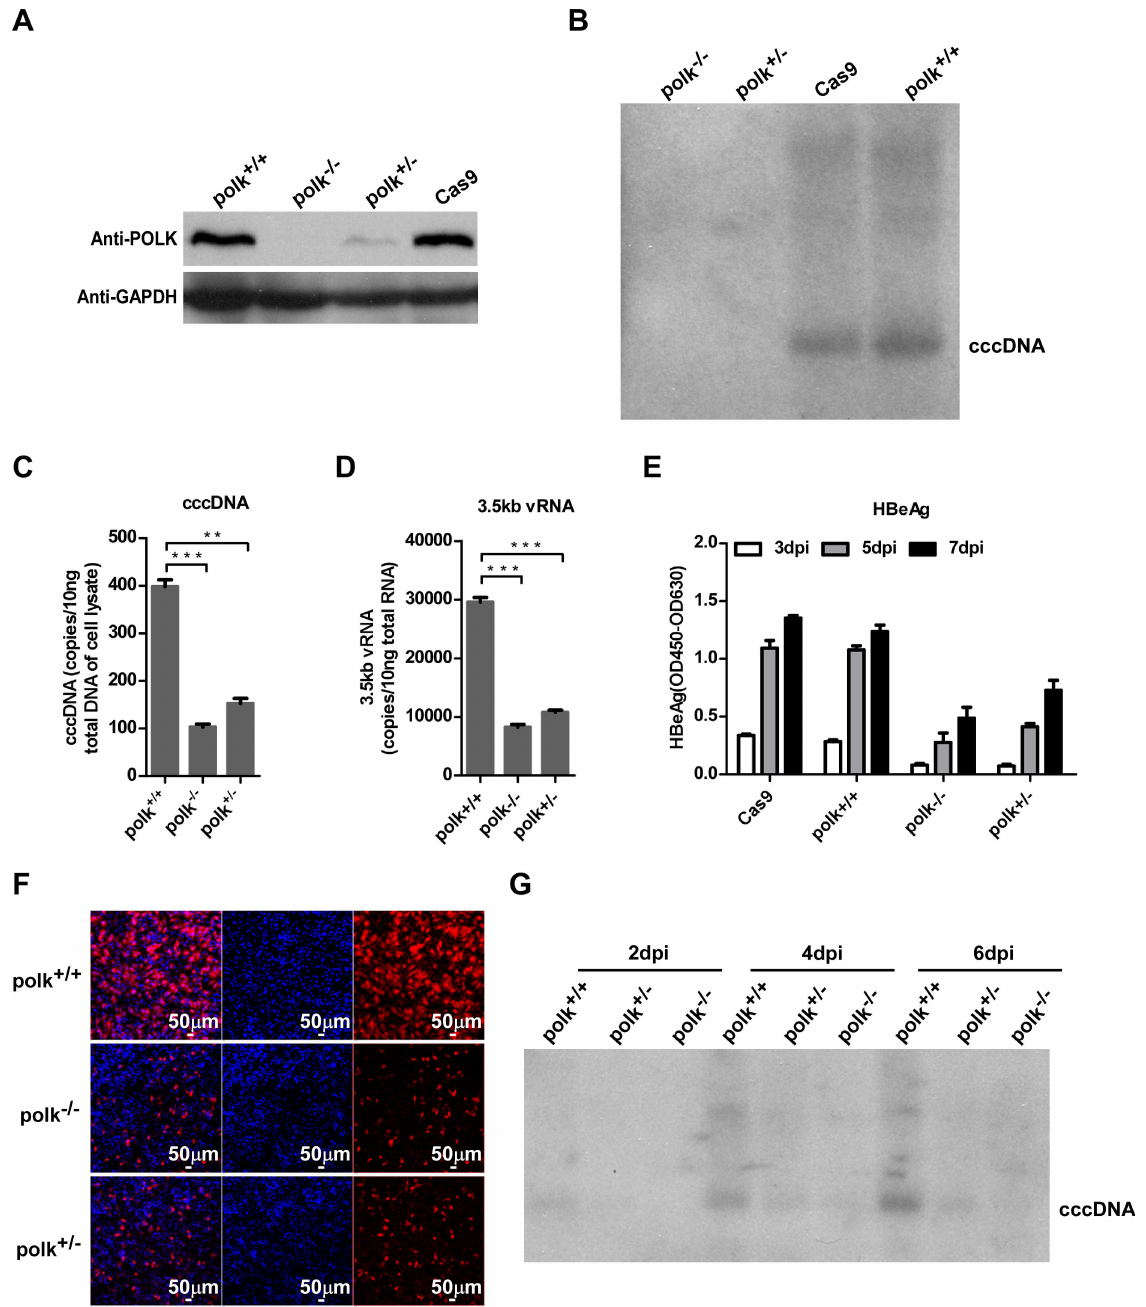
Fig 5. POLK is required for HBV cccDNAsynthesis. (A) POLK expressionin parentalHepG2-NTCP cells and HepG2-NTCP cell clones bearingdisrupted polk gene in one (HepG2-NTCP polk+/- ) or both alleles(HepG2-NTCP polk-/- ) was determined by Western blot assay. GAPDH protein served as a loadingcontrol. (B-F) The indicatedHepG2-NTCP-derivedcell lines were infected with HBV. HBV cccDNA on 7 dpi was detected by Southern blot (B). The amounts of cccDNA (C) and 3.5kb vRNA (D) on 7 dpi were measuredby qPCR assays. Data were analyzedby an unpairedtwo-tailed t test. ** p < 0.01 and *** p < 0.001. Secreted HBeAg from the indicated HepG2-NTCP cells on 3, 5, 7 dpi was measuredby ELISA (E). HBcAg in the infected cultures was stained with 1C10 mcAb (red). Nuclei were stained with DAPI (blue) (F). Images were captured with a Nikon A1-R confocal microscopy, scale bars, 50 μ m. (G) The timecourse of cccDNA synthesis in HBV infected HepG2-NTCP cells with intact or disrupted POLK gene was determinedby Southernblot